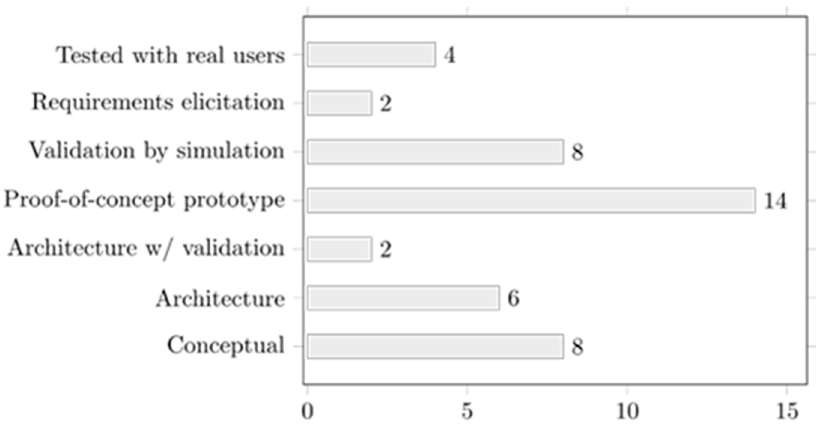
Figure 4. Maturity of the solutions assuming the goal is its deployment in a city.